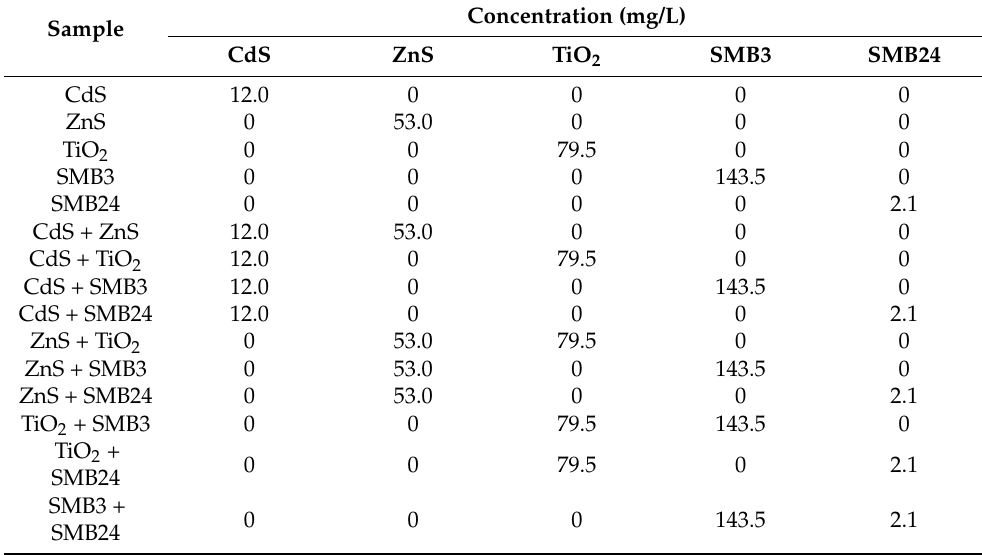
Table 2. The concentrations of NPs used in the binary mixture bioassay